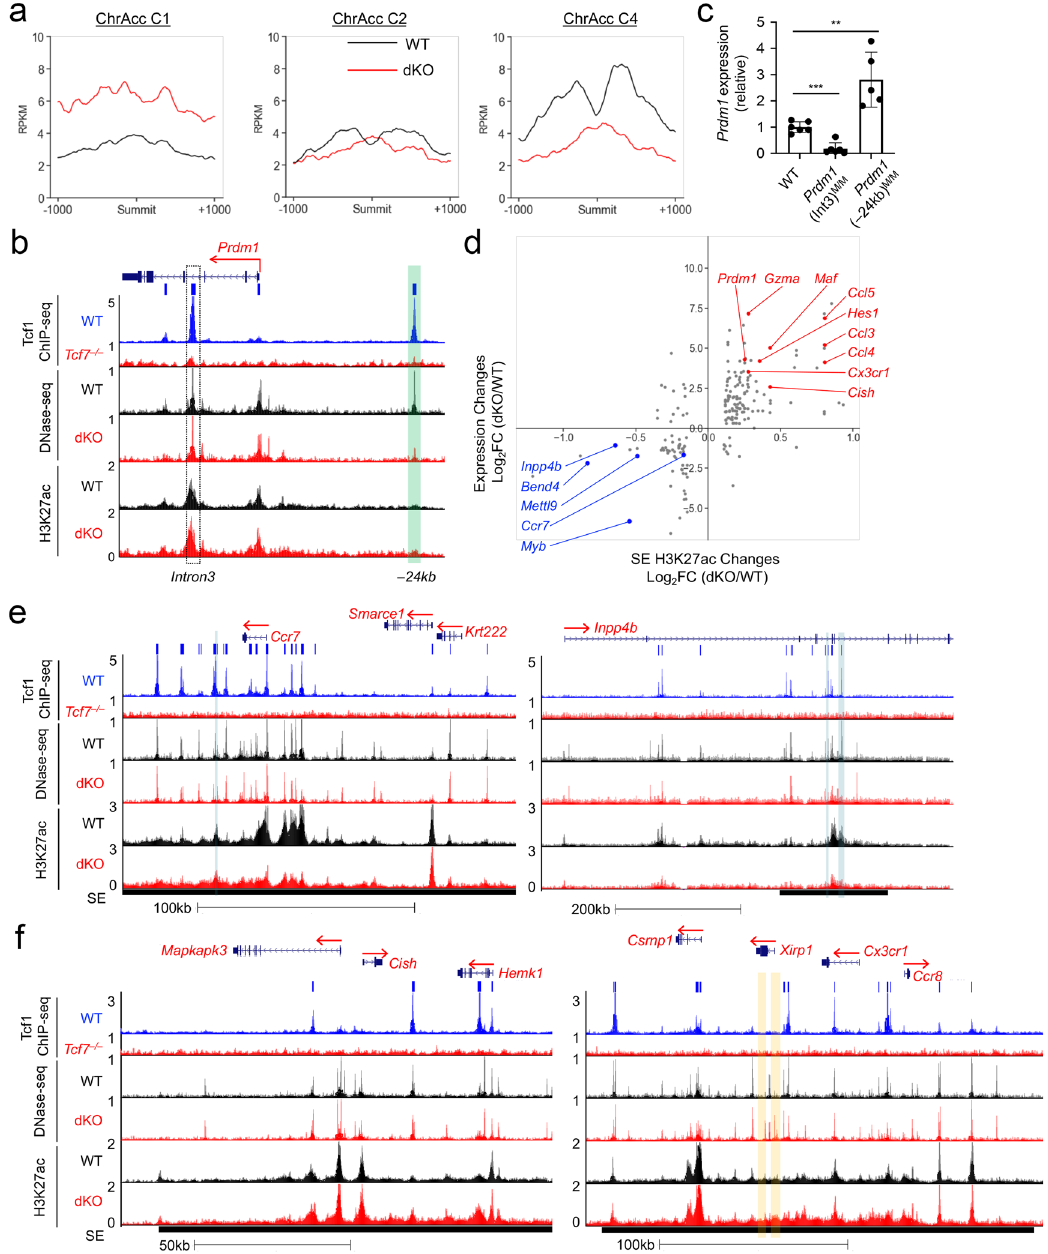
Fig. 6 Tcf1 and Lef1 modulate silencer and super enhancer activity for target gene regulation. a H3K27ac pro fi les at differential ChrAcc clusters C1, C2 and C4 from Fig. 5a. b Tcf1 ChIP-seq, DNase-seq and H3K27ac ChIP-seq tracks at the Prdm1 locus. The 24 kb upstream Tcf1-bound ChrAcc site is in the C2 cluster, as marked with a green vertical bar. The intron 3 Tcf1-bound ChrAcc site, marked with dotted rectangle, was similar in ChrAcc signal strength in WT and dKO CD8 + T cells. c Prdm1 expression was measured with RT-PCR in WT, Prdm1 (Int3) M/M and Prdm1 ( − 24 kb) M/M naïve CD8 + T cells. Data are means ±S.D. from ≥ 3 independent experiments ( n ≥ 5). **, p < 0.01; ***, p < 0.001 as assessed with two-tailed Student ’ s t -test for indicated pairwise comparisons. d Scatterplot showing correlation between H3K27ac changes on differential SEs and expression changes of SE-associated genes, with selected genes marked. e , f Tcf1 ChIP-seq, DNase-seq and H3K27ac ChIP-seq tracks at select SE-associated, Tcf1/Lef1-activated ( e ) or -repressed genes ( f ). Black horizontal bars under each panel denote SE-encompassed regions. Blue vertical bars denote C4 Diff ChrAcc sites in WT-prepotent SEs ( e ), and yellow bars denote C1 Diff ChrAcc sites in dKO-prepotent SEs ( f chromatin at an accessible/open state in mature CD8 + T cells. In direct binding sites within the two clusters but found only modest contrast, ChrAcc sites in C1 cluster that were increased in dKO bias of Motif + Tcf1 peaks in the C2 cluster (Fig. 5g). We next checked H3K27ac state in the ChrAcc clusters. Both C1 and C4 CD8 + T cells showed sparse overlap with high-con fi dence Tcf1 peaks, indicative of indirect mechanisms by which Tcf1/Lef1 TFs ChrAcc sites showed concordant changes in H3K27ac signals, restrain ChrAcc at these locations. Because C2 and C4 ChrAcc with C4 sites showing stronger H3K27ac in WT CD8 + T cells than in dKO cells (Fig. 6a). Speci fi cally, the ChrAcc sites observed clusters were associated with opposite gene expression patterns in in Tubb3 upstream and Bach2 intron regions were associated with dKO CD8 + T cells, we examined relative enrichment of Tcf1